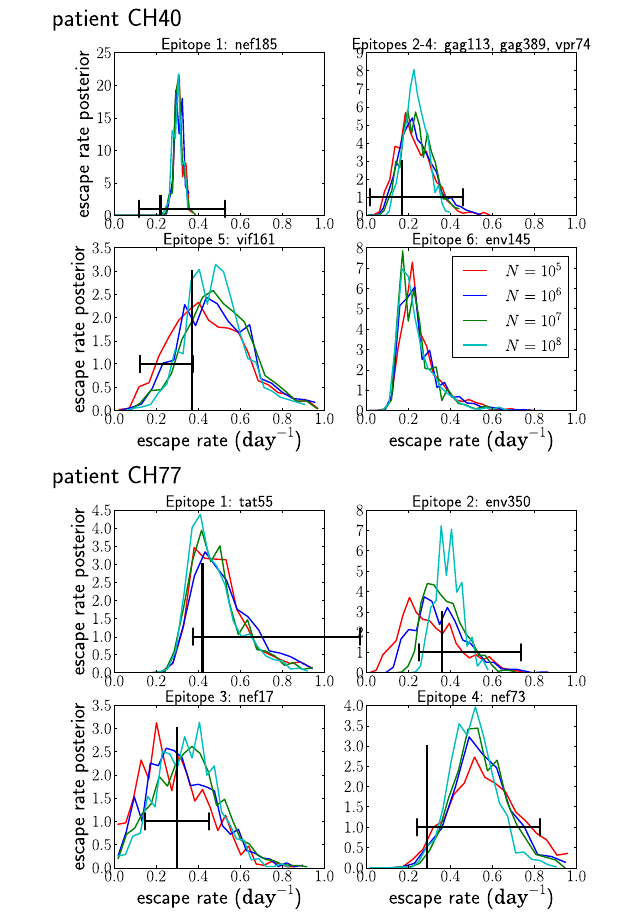
genotype trajectories for patient CH40 with parameters N = 10 7 and µ = 10 − 5 . Each curve is labeled by an epitope but should be understood as the frequency of the genotype that has escaped at this and all previous epitopes. Note that no data are available to differentiate epitopes gag113, gag389, and vpr74. For those, we assume an arbitrary order and equal escape rates as explained in the section on unobserved